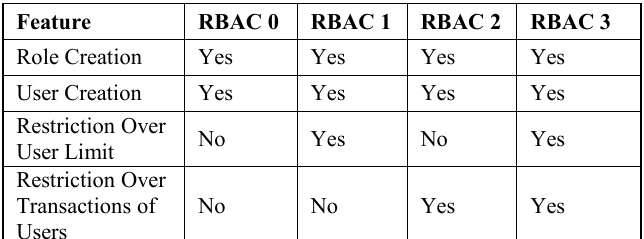
Table 1. Different RBAC models